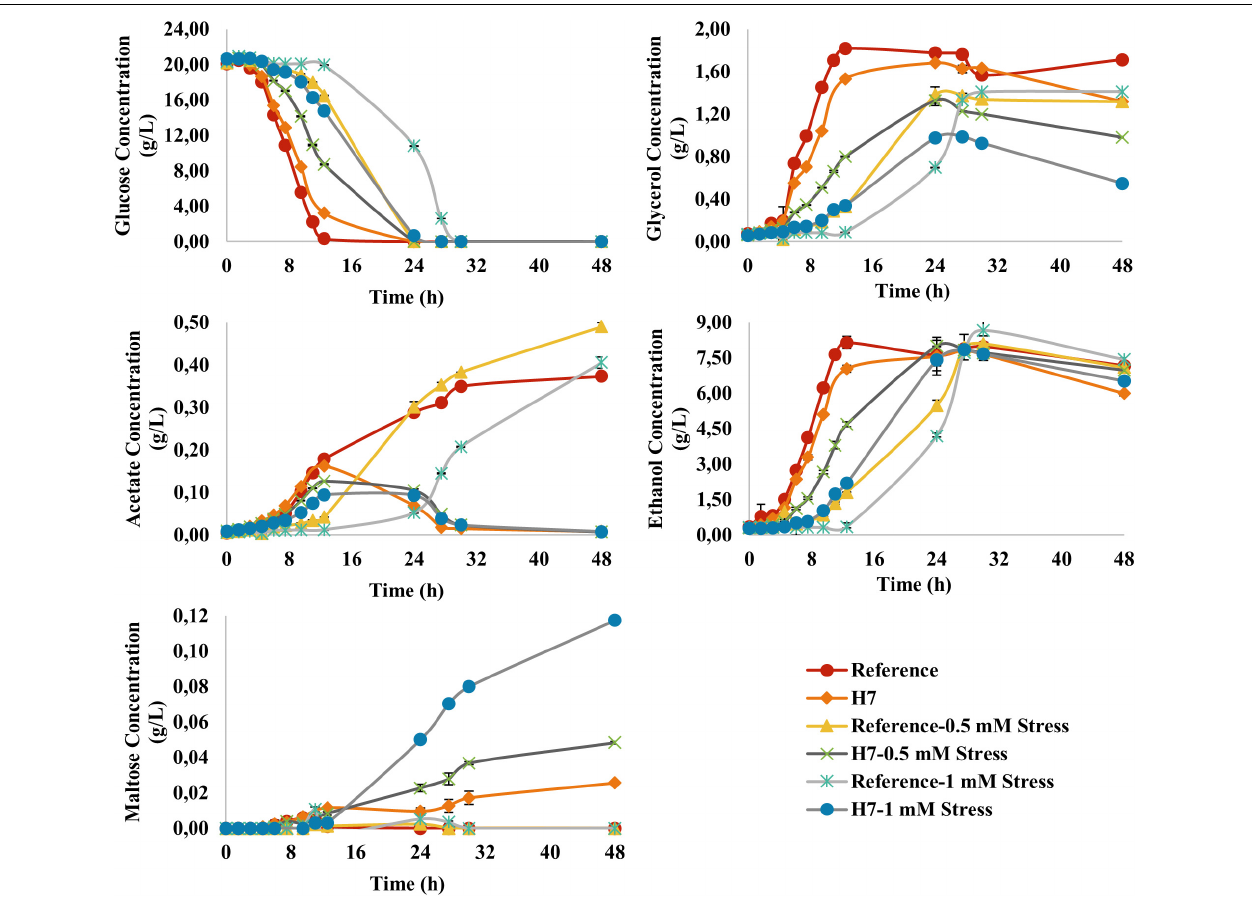
FIGURE 6 | Residual glucose concentration, glycerol, ethanol, acetate and maltose production (g L - 1 ) profiles of the reference strain and H7 in the absence and presence of 0.5-mM and 1-mM H 2 O 2 as the oxidative stress factor. The cultures were grown in YMM at 30 ◦ C and 150 rpm for 48 h.